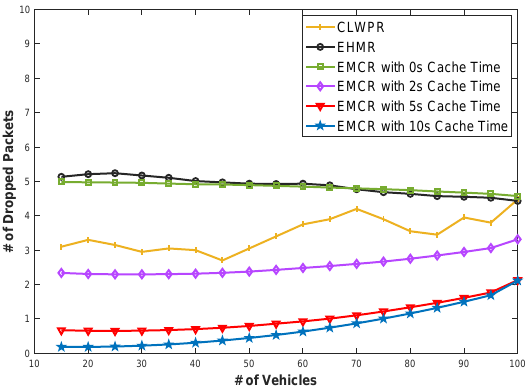
Figure 16. Number of dropped packets vs. Number of